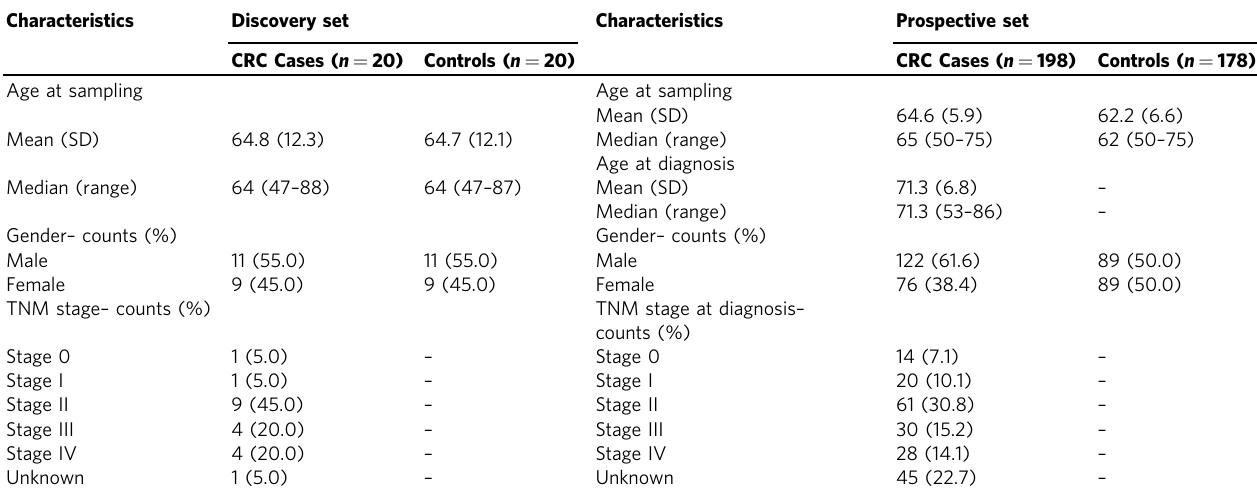
Table 1 Characteristics of the study populations.